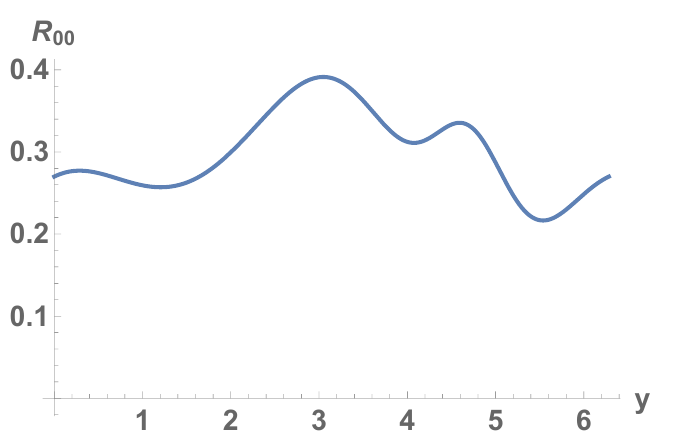
Figure 1 . R 00 of (3.2) as periodic function of y with period 2 (cid:25) ; computed for L = 1 from (3.4) with a = 0 : 2 and H = 0 :